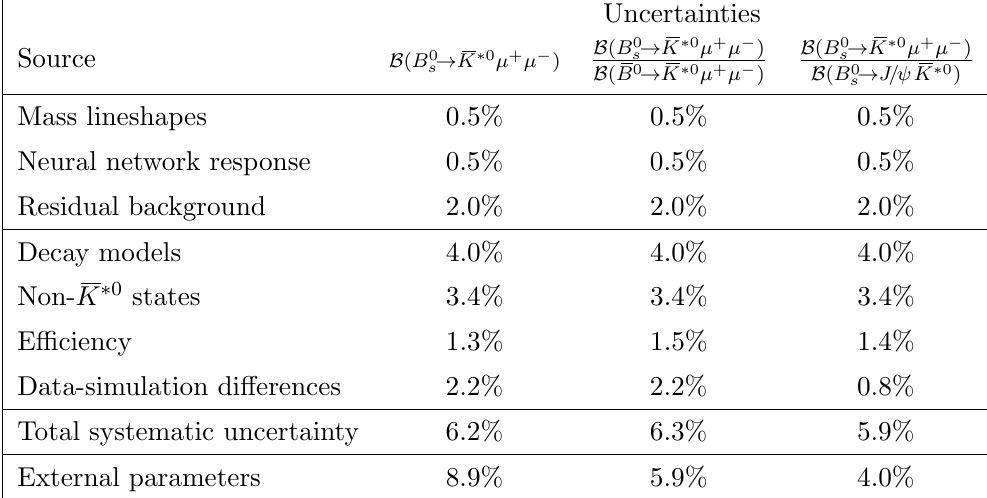
! K (cid:3) 0 (cid:22) + (cid:22) (cid:0) ), the second to s ! K (cid:3) 0 (cid:22) + (cid:22) (cid:0) ) = B ( B 0 ! J= K (cid:3) 0 ), s s